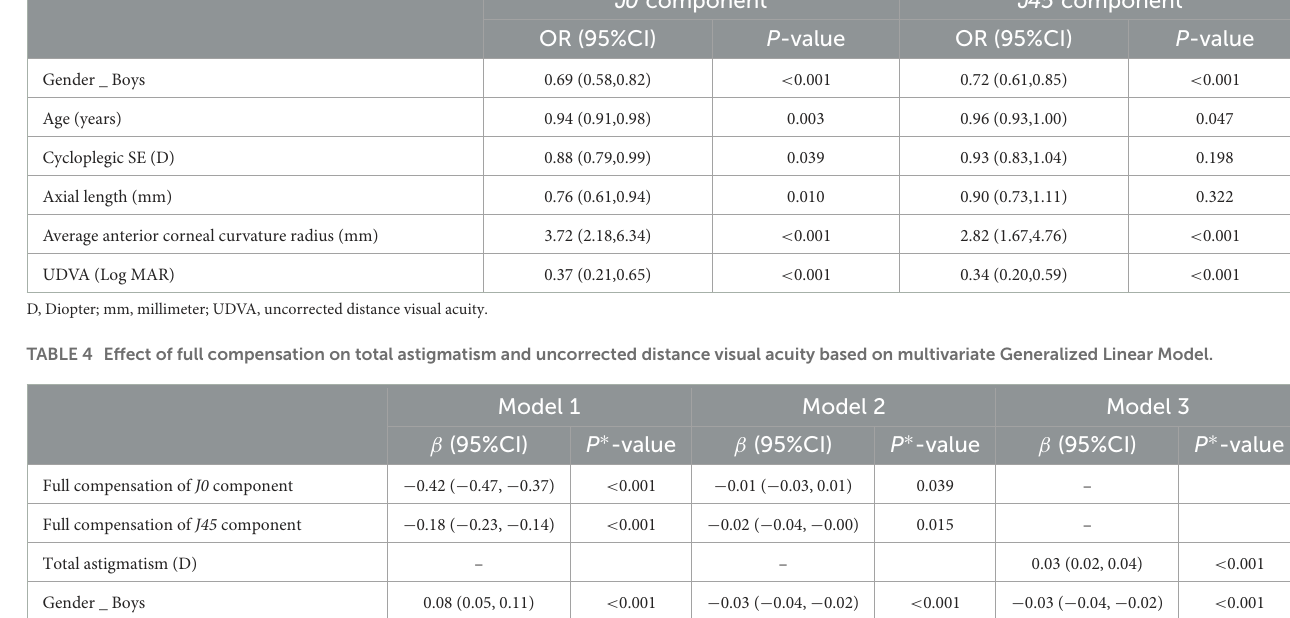
TABLE 3 Multivariate Logistic regression analysis assessing related factors for children with full compensation.